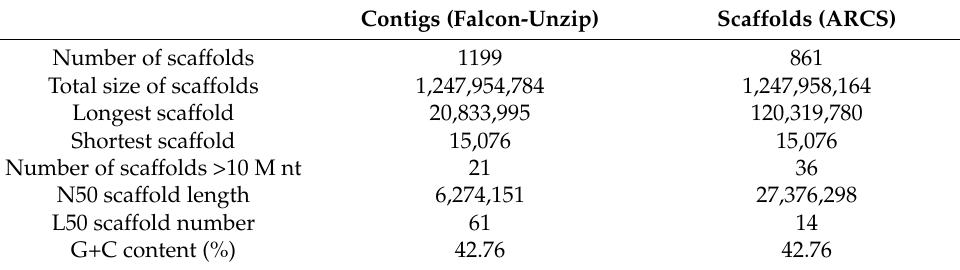
Table 1. Summary of the Macronectes giganteus genome